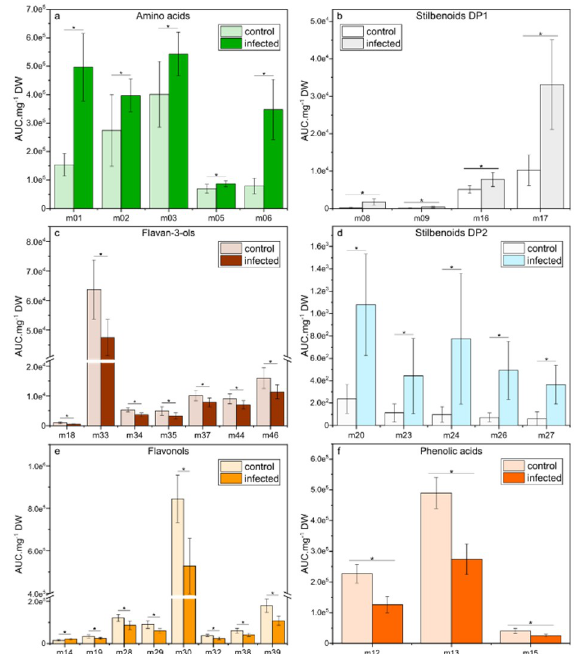
Figure 5. Relative concentrations of the selected metabolites in leaves of Vitis vinifera L. cv. Malbec upon downy mildew infection at 6 dpi. Data are mean values ± standard deviation (control: n = 15; infected: n = 12). Asterisk: significance difference from control ( p < 0.05).